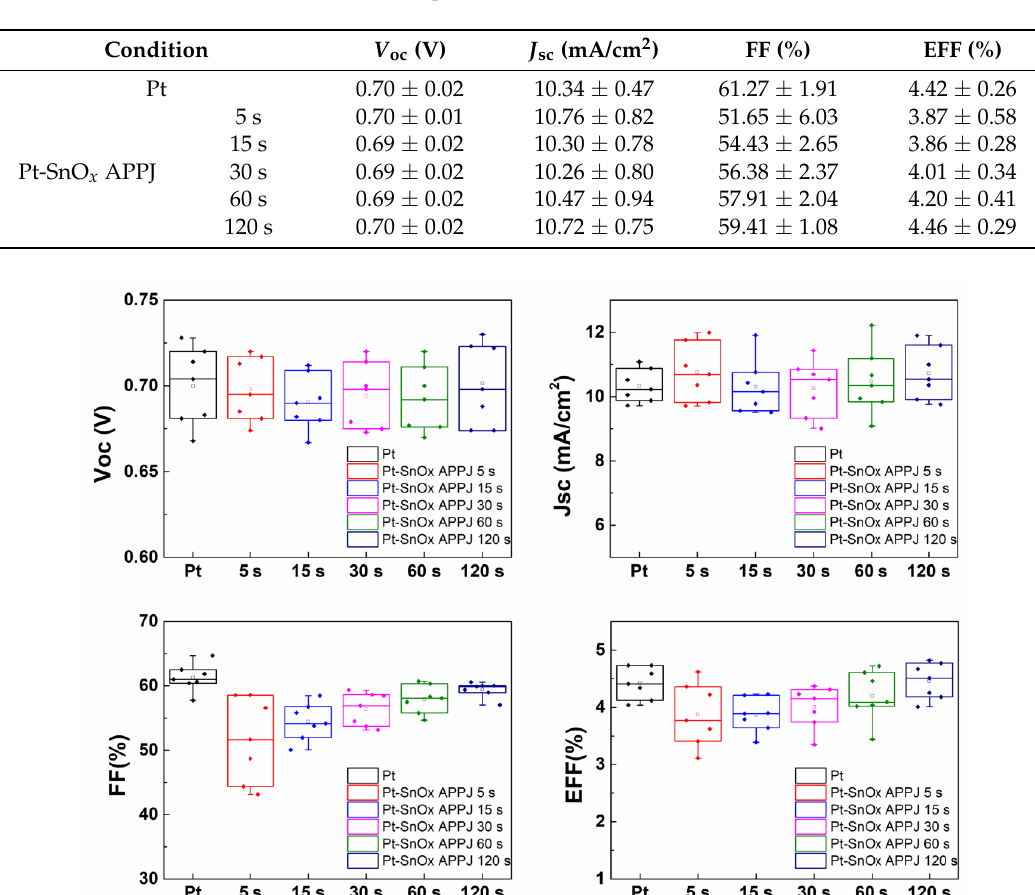
Table 4 Photovoltaic parameters of DSSCs with different CEs. Figure 7. Photocurrent density-voltage curves of DSSCs with various CEs. Figure 7. Photocurrent density-voltage curves of DSSCs with various CEs. Table 4. Photovoltaic parameters of DSSCs with different CEs.